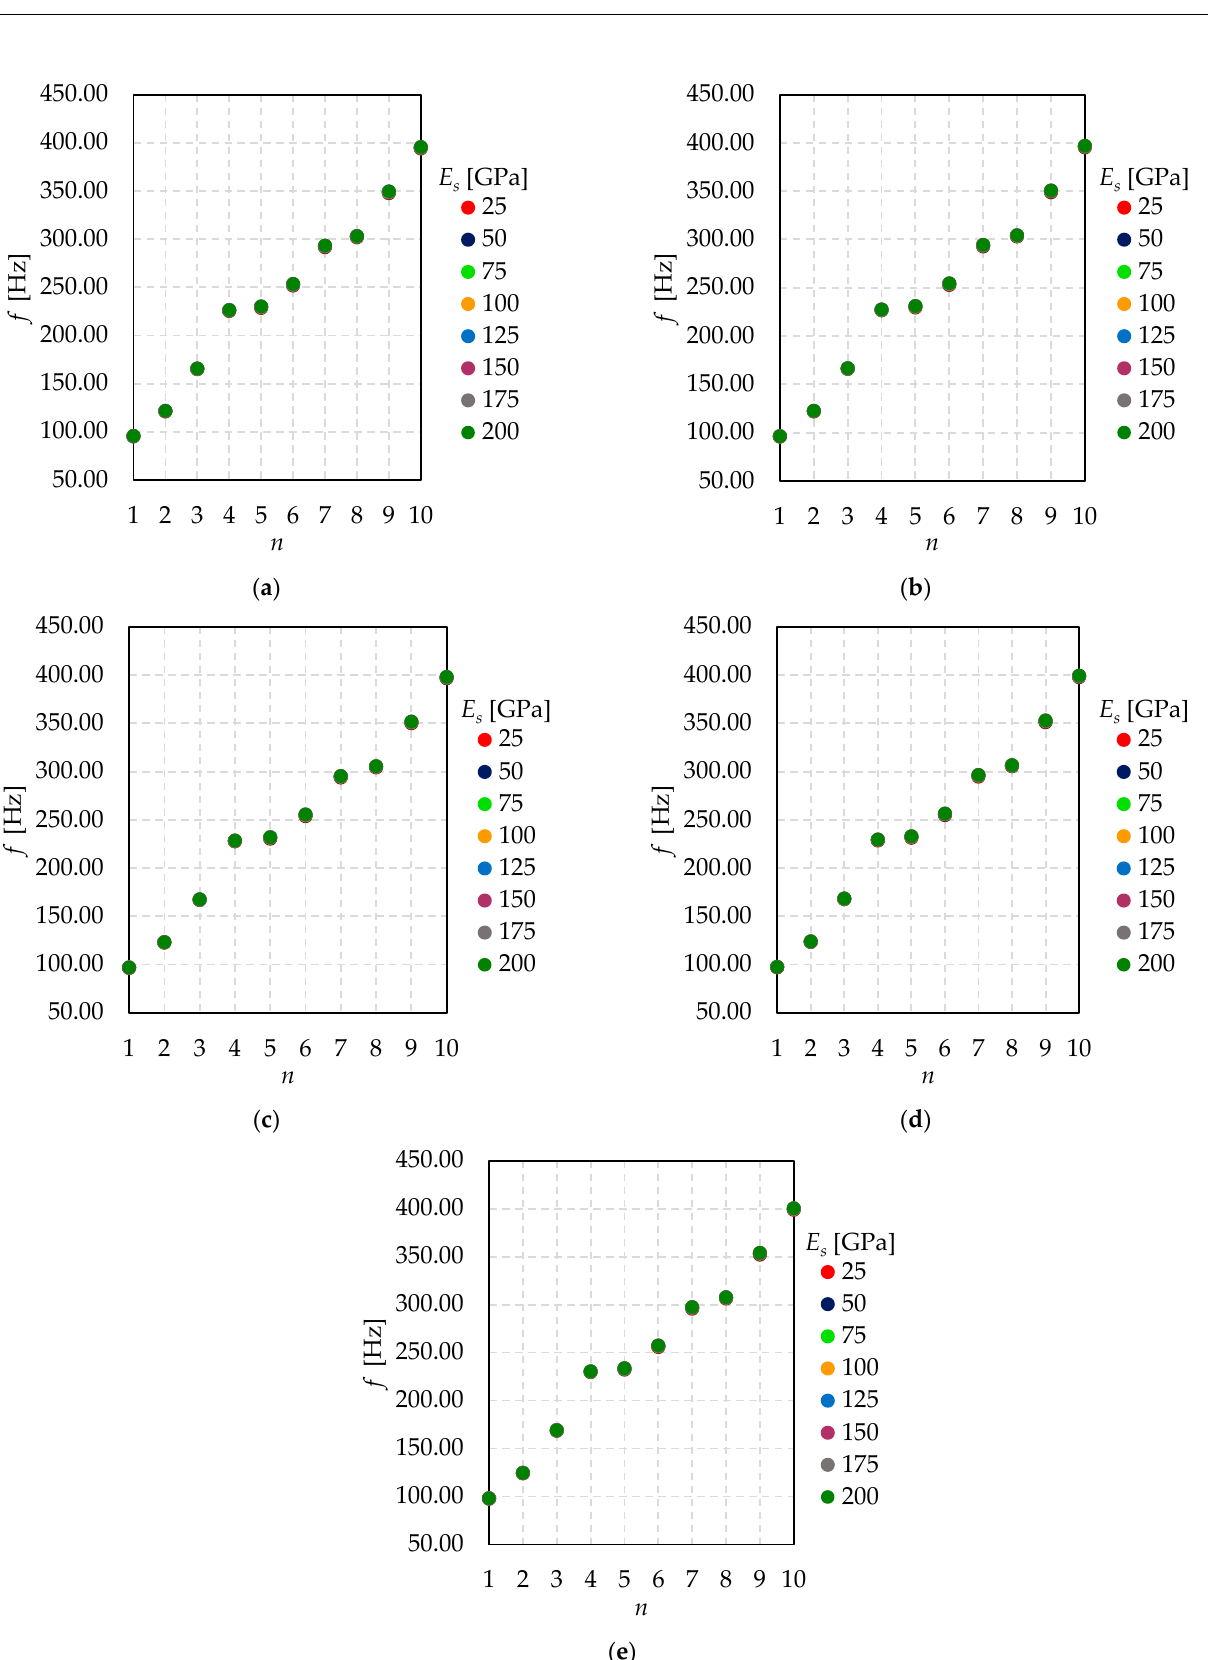
Figure 16. The relationship between natural frequency ( f ) and mode shape number ( n ) for different sealing Young’s modulus ( E s )—( a ) E p = 160 GPa; ( b ) E p = 170 GPa; ( c ) E p = 180 GPa; ( d ) E p = 190 GPa; ( e ) E p = 200 GPa.